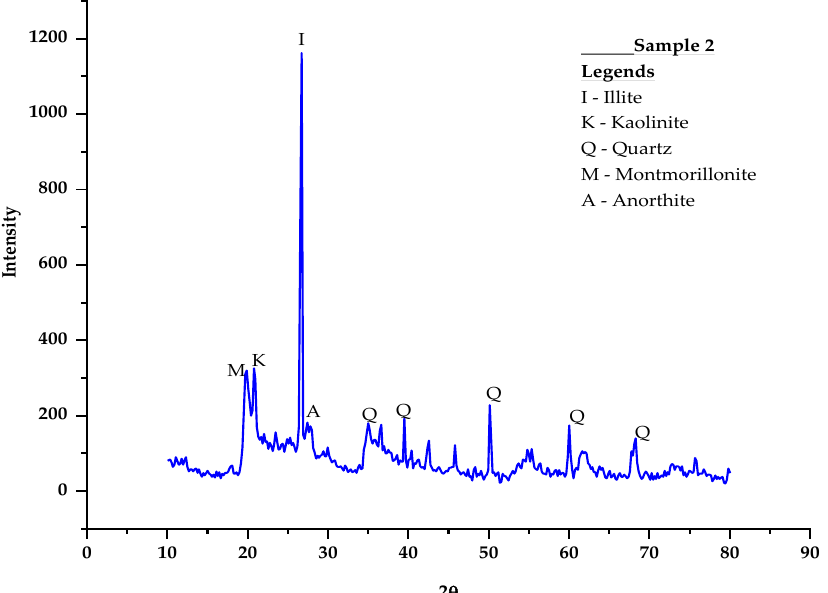
Figure 8. X-ray diffraction patterns and mineral types present in soft clay soils of samples 1 and 2 . plotted as intensity on the y-axis vs. 2 θ angle on the x-axis (Figure 8). The intensity is usually